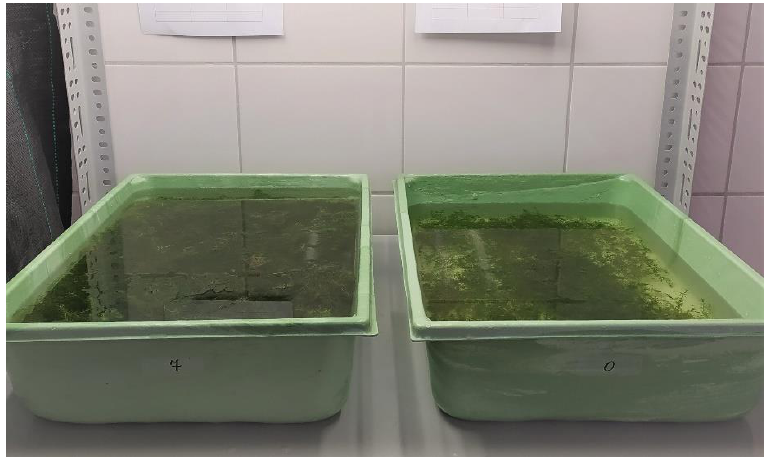
Figure 3. Aldrovanda vesiculosa plants during acclimatization to ex vitro conditions.